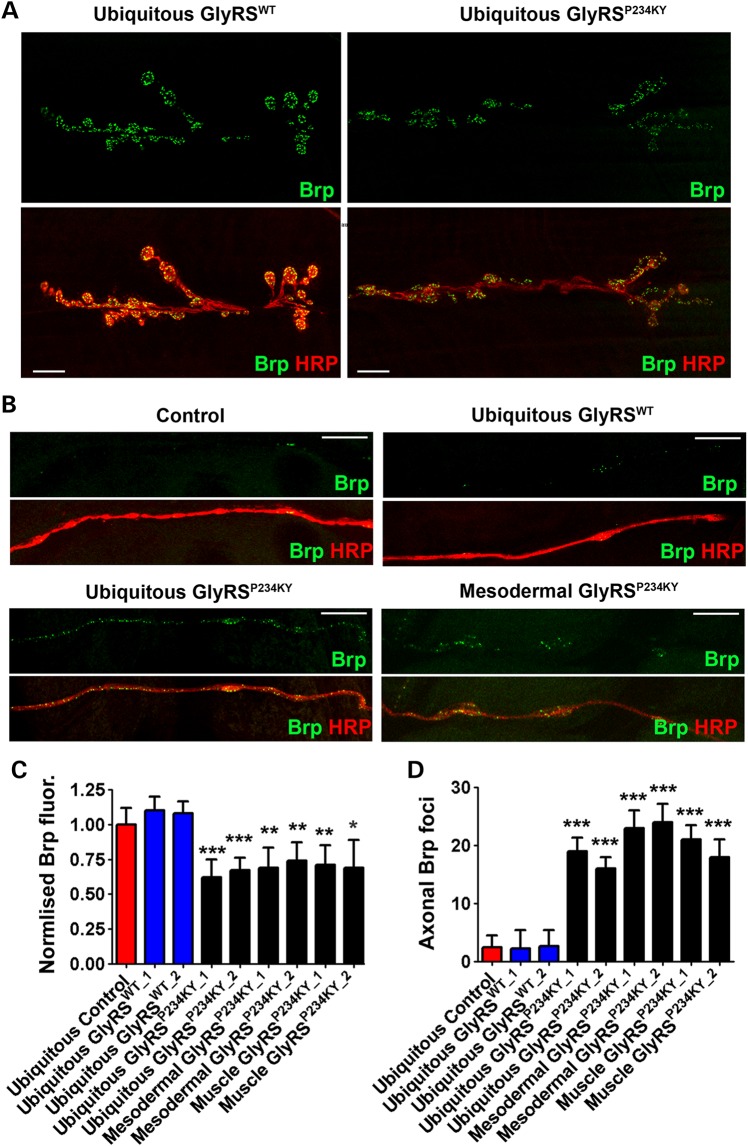
garsP234KY larvae display NMJ denervation and axonal defects. (A) Representative NMJs from late L3 larvae ubiquitously (1032-GAL4) expressing garsWT and garsP234KY. (B) Representative axonal segment pictures taken of the transverse nerve (TN) over muscles 6 and 7 in abdominal segment A2 in late L3 control, garsWT (1032-GAL4), garsP234KY (1032-GAL4) and garsP234KY mesodermal (how-GAL4) larvae. (C) Quantification of the normalized Brp fluorescence at the NMJ showing ubiquitous, mesodermal and muscle garsP234KY expression leads to reduced Brp signal. (D) Quantification of the number of Brp-positive foci in the TN showing that ubiquitous, mesodermal and muscle garsP234KY expression leads to increased Brp accumulation. For all graphs, *P < 0.05, **P < 0.01, ***P < 0.001 Bonferroni's/Dunn's multiple comparison test. At least 20 NMJs and axons were analysed per genotype. Scale bars = 10 µm.